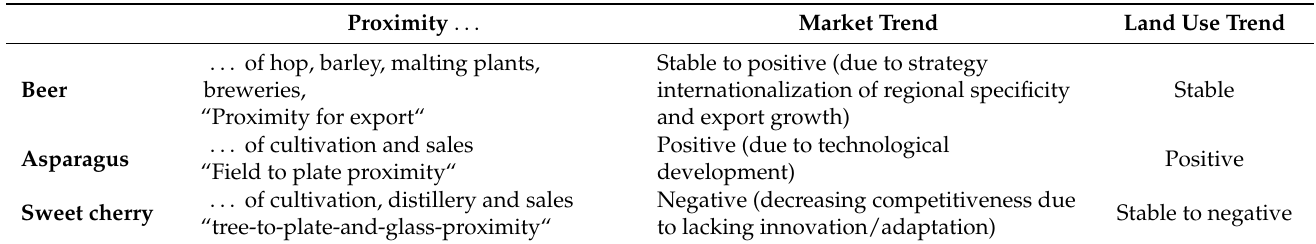
Table 2. Development trends and the role of proximity for the analyzed products. Proximity . . . Market Trend Land Use